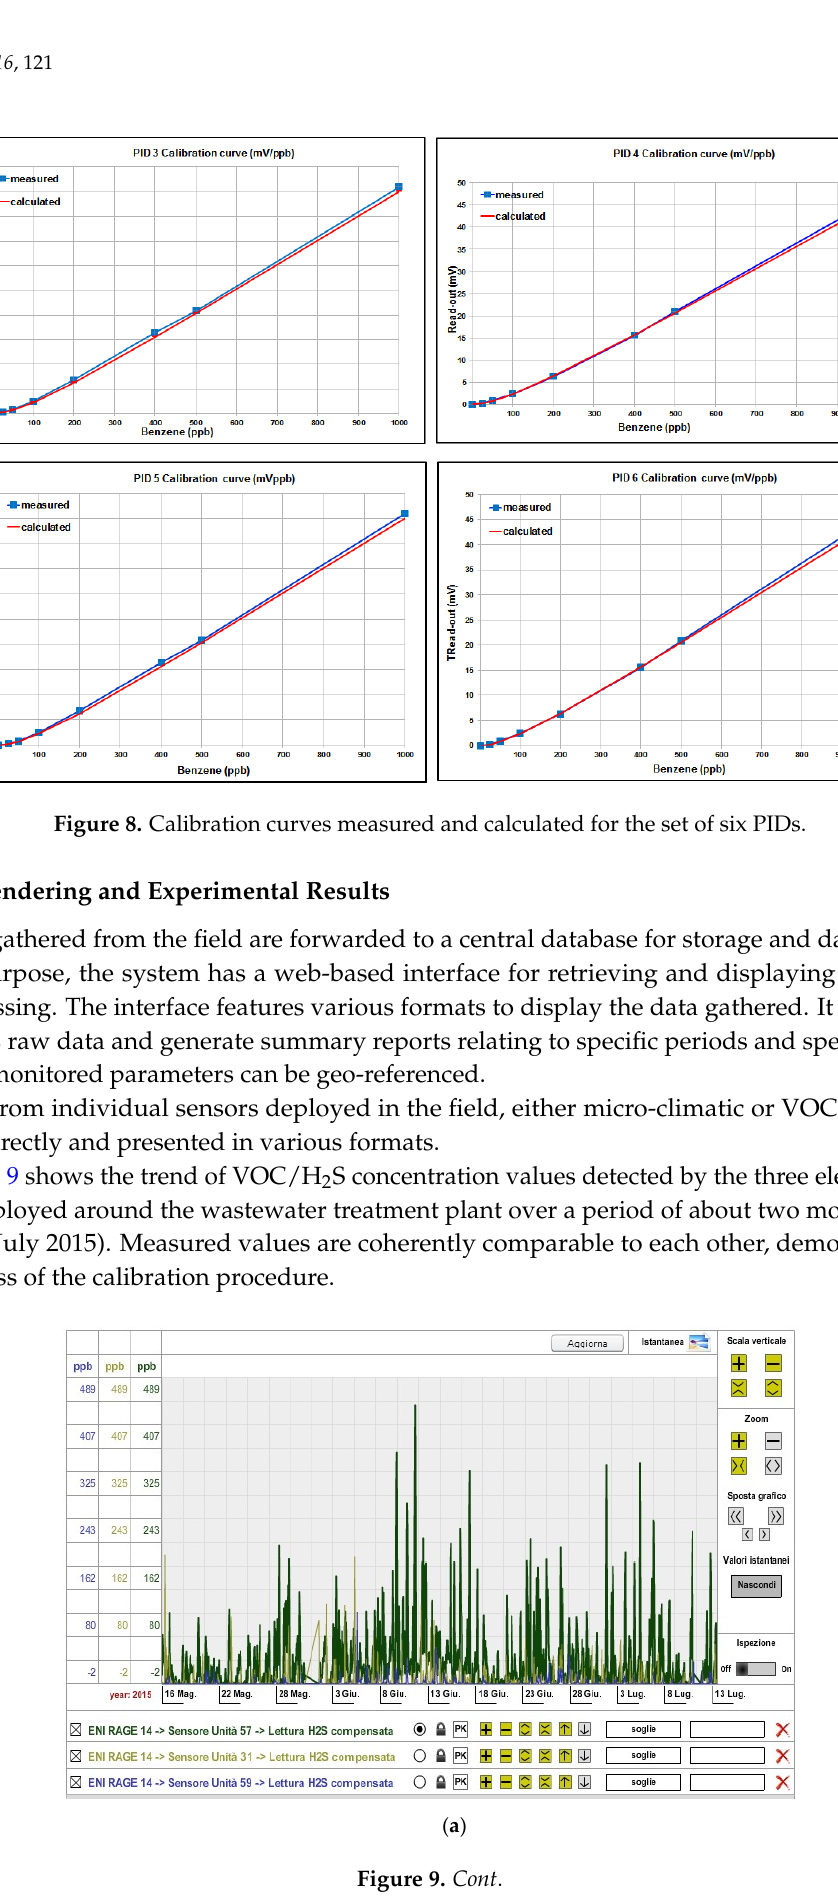
( b ) Figure 9. ( a ) VOC and ( b ) H 2 S concentrations in the wastewater treatment plant area. VOC/H2S Concentration and Weather-Climatic Variations Correlating the microclimatic and wind parameters (air temperature/humidity and WSD) with gas concentrations proved to be very effective for increasing gas readout accuracy and, moreover, for mapping gas concentrations with respect to wind direction, in order to identify possible gas sources. In fact, when gas sources must be identified, the correlation between WSD and gas concentration is vital. For this reason, a graphic representation that relates these two parameters can be very useful for interpreting results. The plots in Figure 11, related to the Mantova installation, provide an example of that possibility, in which a suitable VOC detector array is deployed (see Figure 10), with three detectors in a row on both the northern and southern sides of the chemical plant. The graph in Figure 11 represents the trend of VOC concentration values (detected by the six PIDs deployed around the chemical plant) over a five-day period.